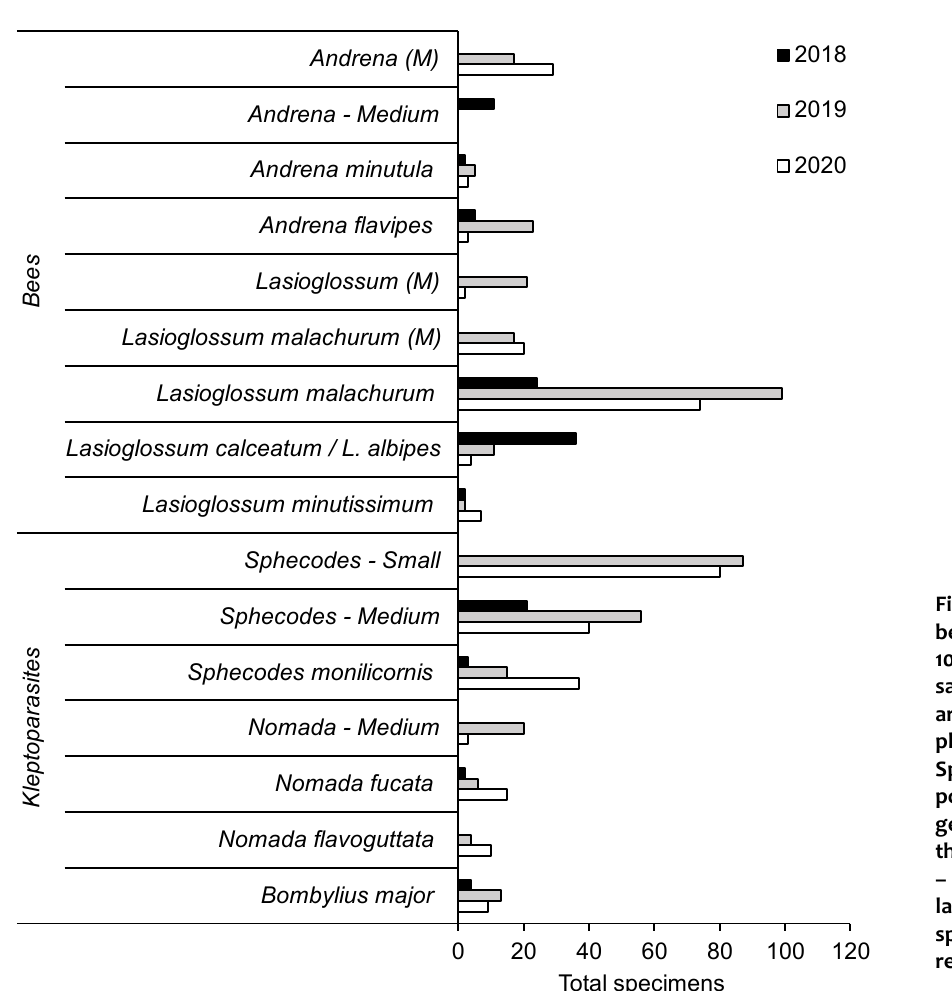
Figure 1: Total number of bees and kleptoparasites